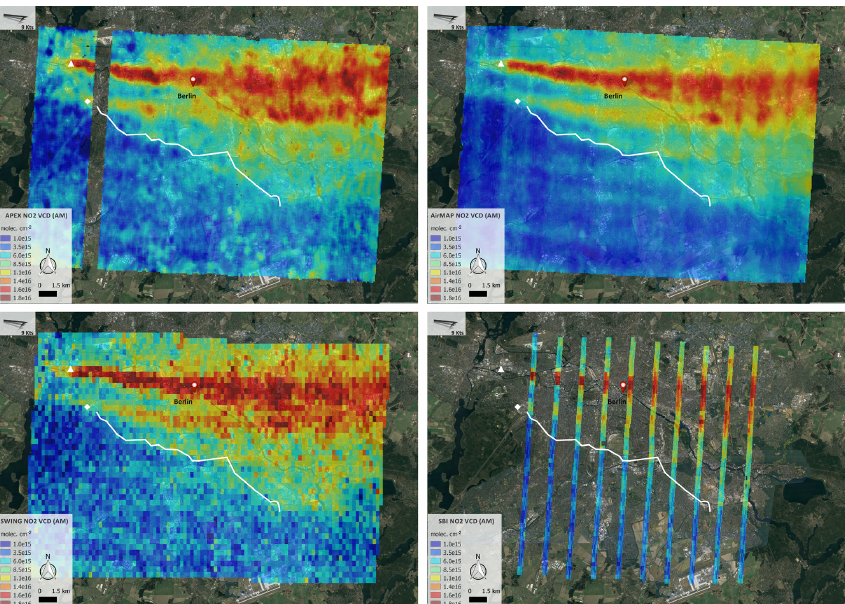
Figure 11. Tropospheric NO 2 VCD maps retrieved from APEX, AirMAP, SWING, and SBI for the morning flight over Berlin on 21 April 2016 (Google, TerraMetrics). The key contributing NO 2 emission sources are indicated by a white triangle (power plant Reuter West) and white diamond (Messe Berlin). The highways A100 and A113, running south of the city, are marked by the white line. Hourly averaged wind vectors indicate the surface wind at 08:00 (light grey, 3.3ms − 1 ), 09:00 (grey, 4.9ms − 1 ), and 10:00 (black, 5.1ms − 1 ) UTC. The average surface wind speed is indicated on the maps.